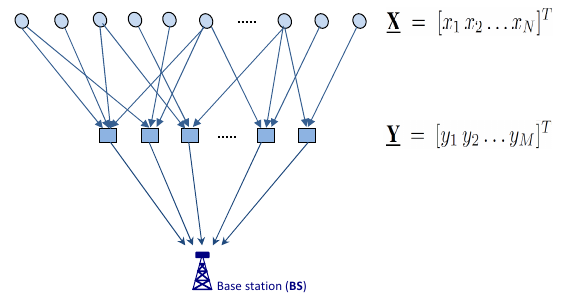
Figure 1. M random walks sample N sensors randomly creating